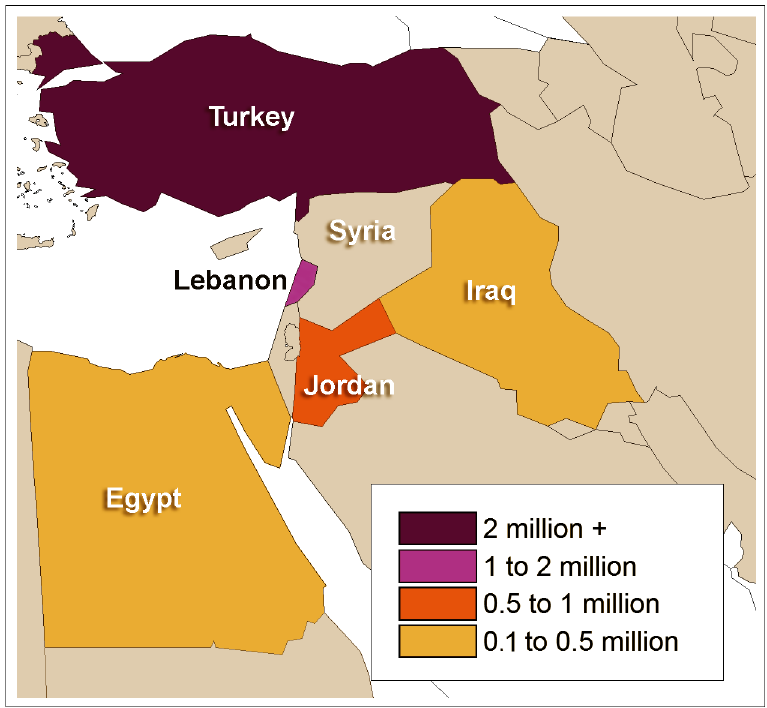
Fig 2. The displacement of Syrian refugees (data from UNHCR, Syria Regional Refugee Response: Inter-agency Information Sharing Portal)